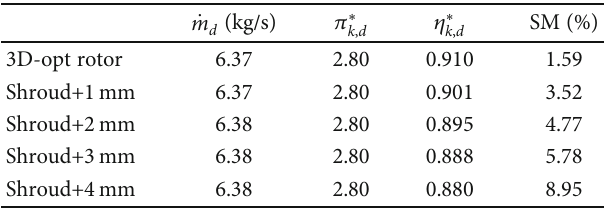
Figure 13: Schematic for the expansion of upper meridian plane. Table 6: Aerodynamic performance of fi ve rotors.